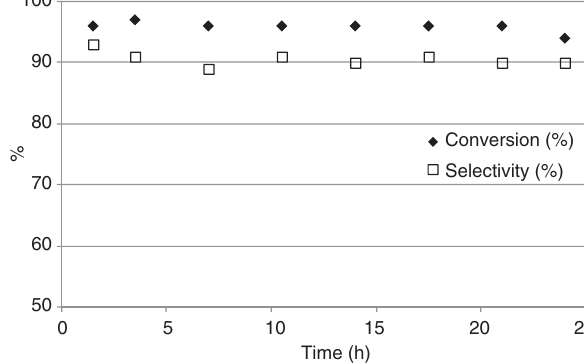
Table 6: Reaction conditions and results with other amines. a